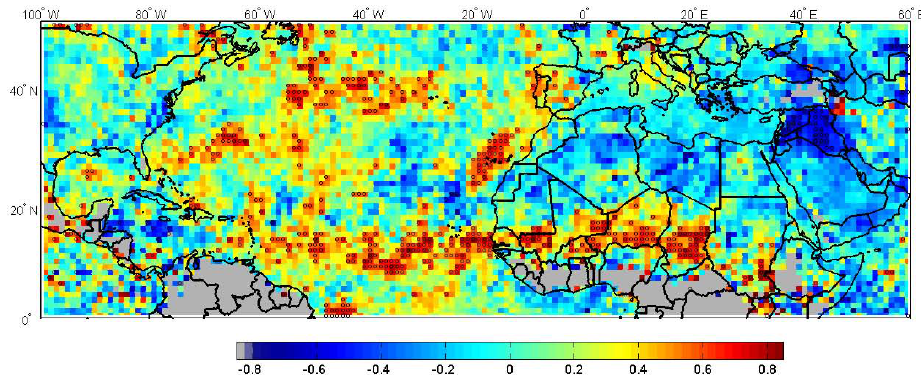
Fig. 5. Lagged correlation of summertime average (JJA) mean AOD anomaly with winter (DJ) mean ENSO Index leading by 6 months over the North Atlantic and surrounding regions (0–50 ◦ N, 100 ◦ W–60 ◦ E). Dots indicate significance at 95% confidence level. Regions shaded in grey indicate insufficient aerosol sample